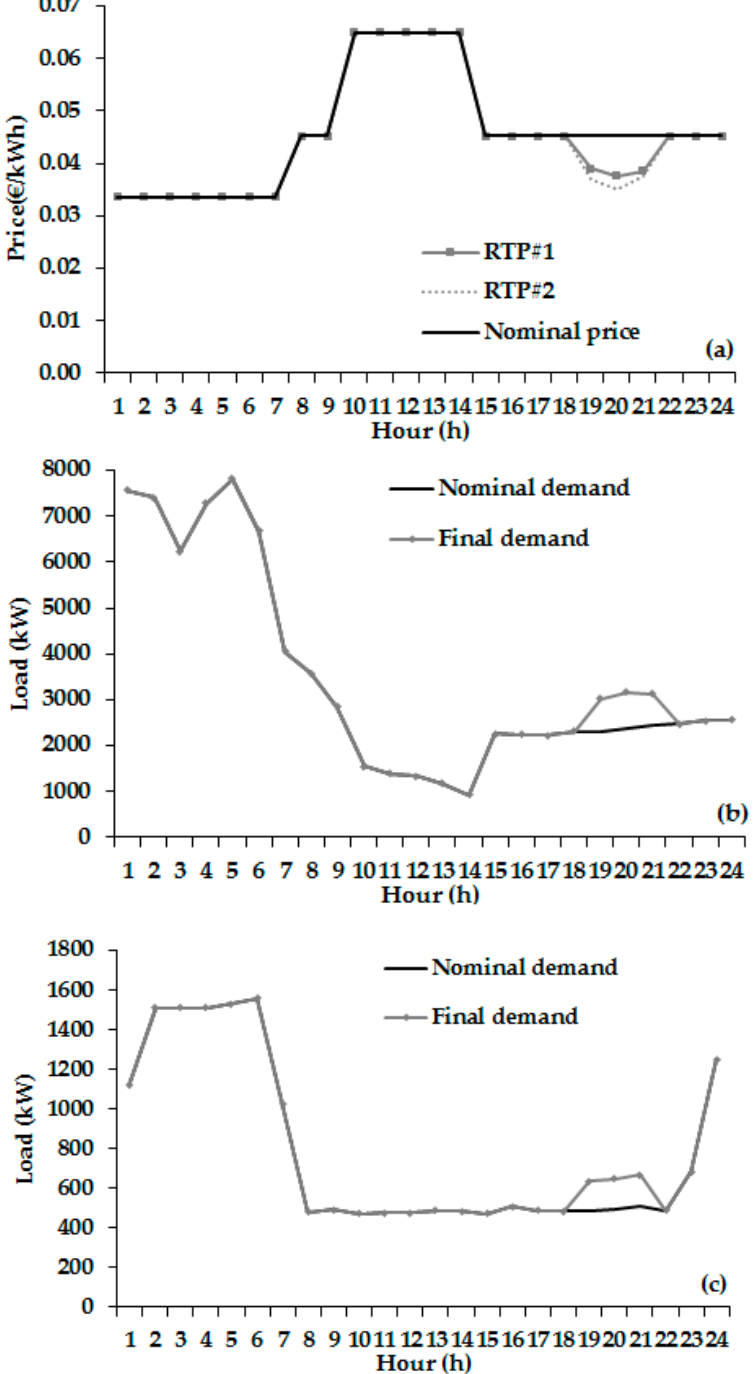
Figure 19. VF objective results with linear DR model: ( a ) Nominal price and RTP; ( b ) nominal and final demand of consumer 1 and ( c ) nominal and final demand of consumer 2.